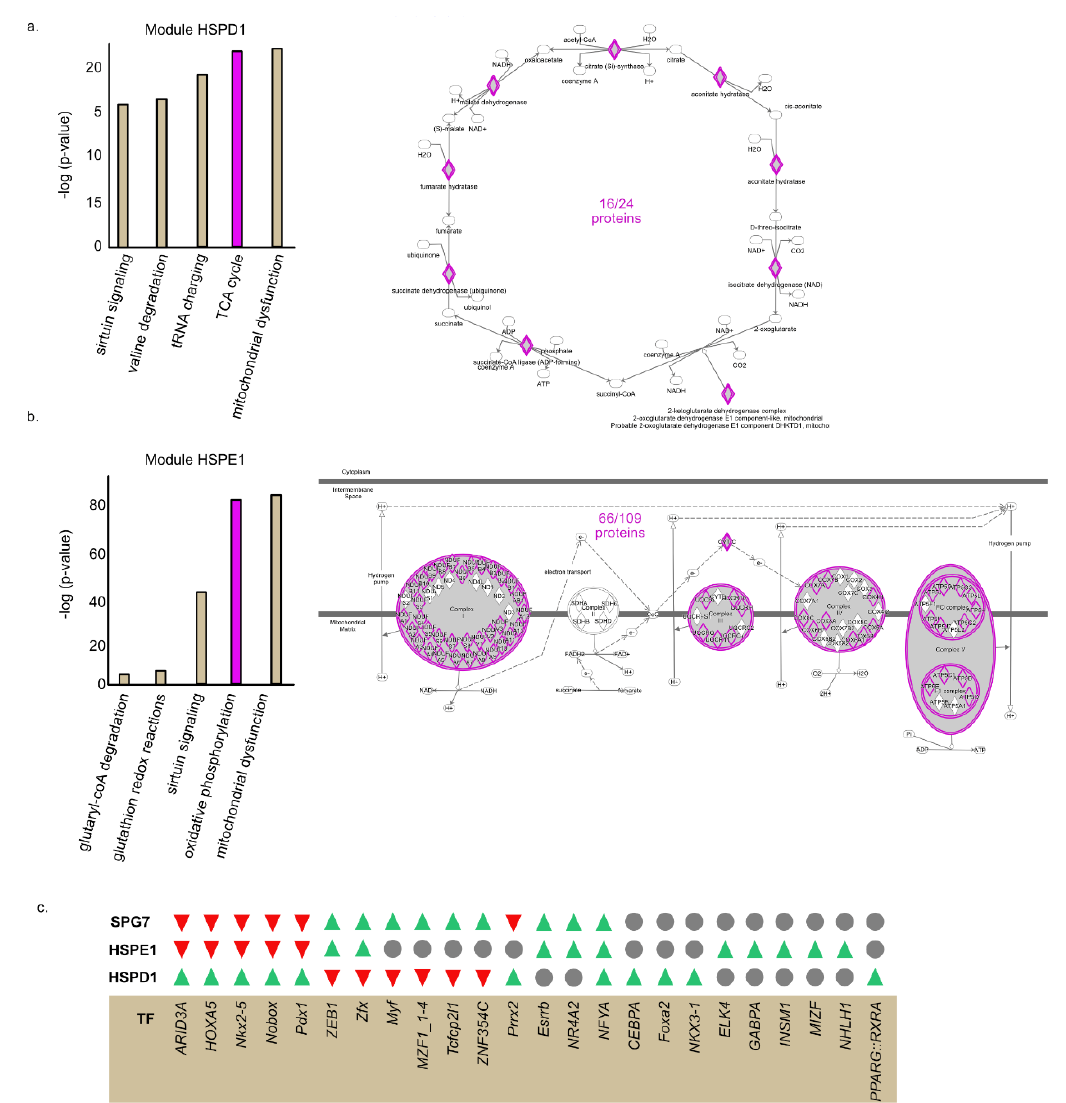
Figure 3. Proteins in each module are enriched for distinct mitochondrial pathways and distinct transcription factor motifs in their promoters. a, b. proteins belonging to each module were interrogated using Ingenuity Pathway Analysis (IPA) to identify biological pathways enriched in each list of proteins. ( a ) Module HSPD1 ( b ) Module HSPE1. ( c ) Transcription factor binding sites enriched or depleted in each module were identified using oPOSSUM analysis. Green = enriched in the module; Red = depleted in the module; Gray = not enriched or depleted in the module.